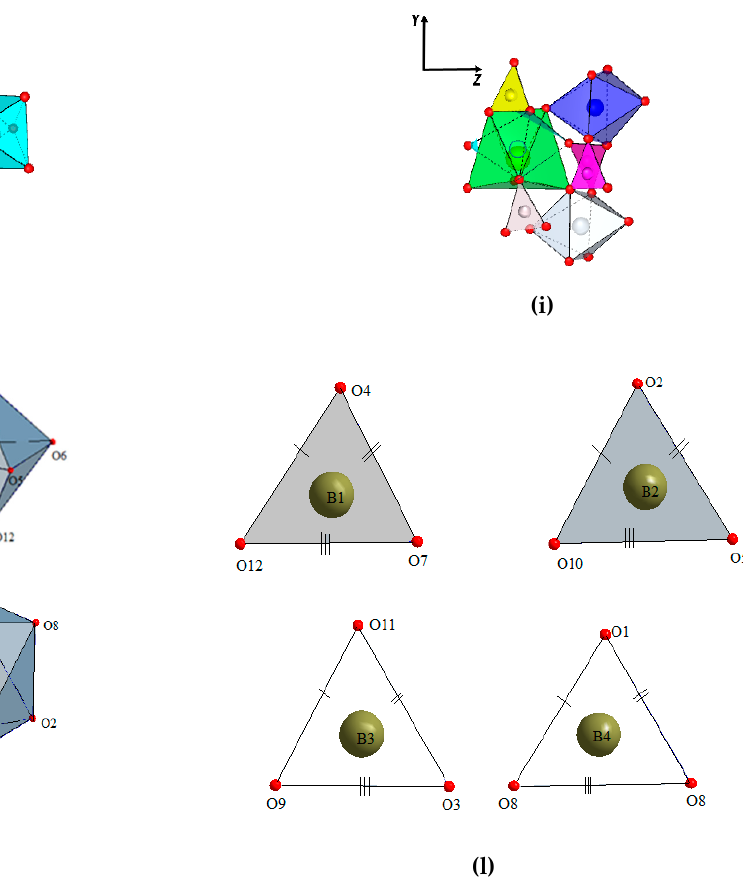
Figure 8. The unit cell of the LnM 3 (BO 3 ) 4 structure (space group Cc ) projected onto the ( a ) XZ, ( b ) XY, ( c ) YZ planes; Combination of the coordination polyhedra projected onto the ( d ) XZ, ( e ) XY, ( f ) YZ planes; Combination of selected coordination polyhedra projected onto the ( g ) XZ, ( h ) XY, ( i ) YZ planes; Coordination polyhedra for the ( j ) Ln , ( k ) M1–M3 , ( l ) B1–B4.